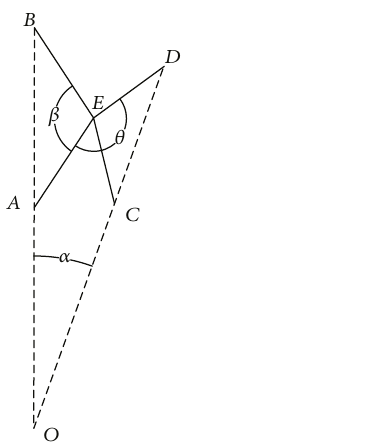
Figure 5: Scissor elements with a folding angle.